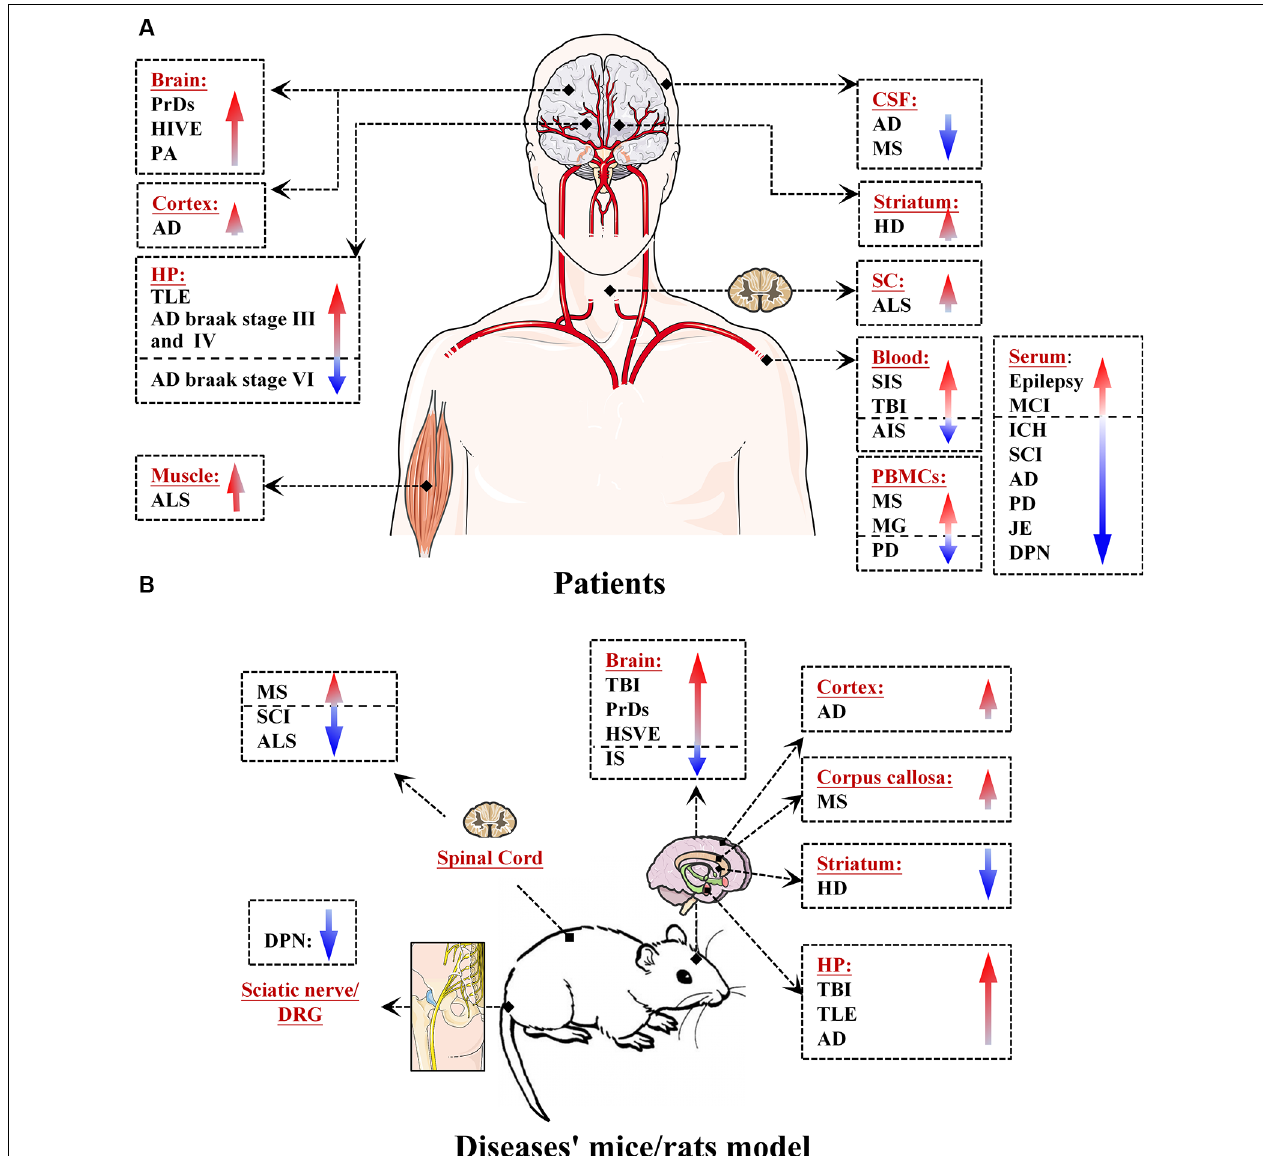
FIGURE 1 | Expression levels of microRNA-146a (miR-146a) in patients and in mouse/rat models of neurological diseases. (A) Expression of miR-146a in the brain, cortex, hippocampus (HP), cerebrospinal fluid (CSF), spinal cord (SC), blood, serum, peripheral blood mononuclear cells (PBMCs), and muscle of patients with neurological diseases. (B) Expression of miR-146a in the brain, cortex, HP, striatum, corpus callosum, SC, sciatic nerve, and dorsal root ganglion (DRG) neurons of model mice/rats with neurological